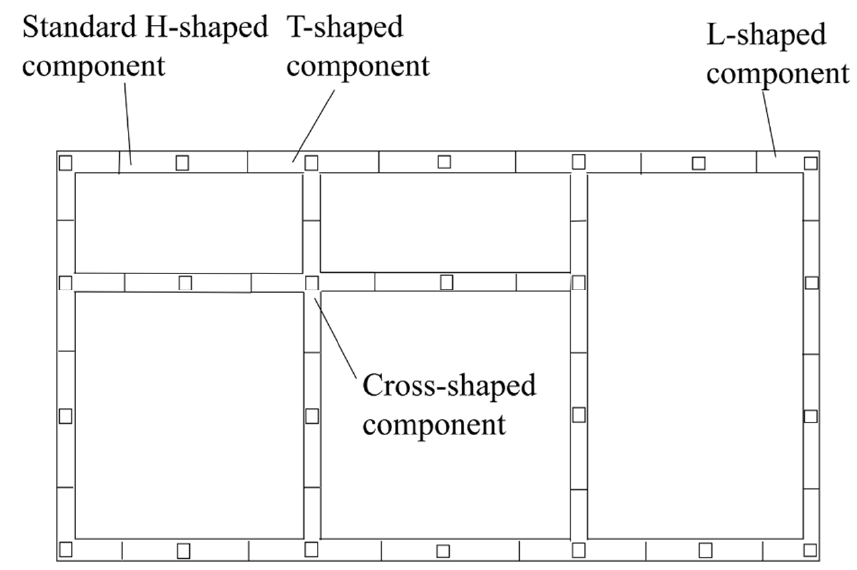
Figure 4. Schematic diagram of a vertical load-bearing unit.